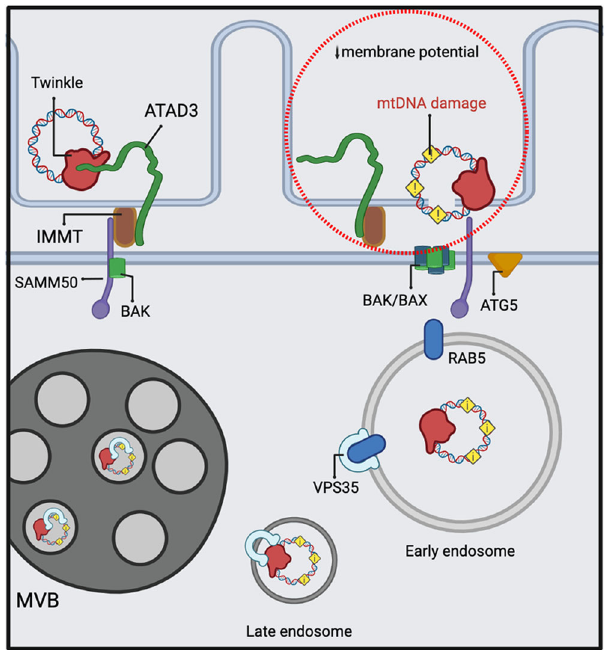
Fig. 9 | Proposed model for mitochondrial nucleoid extraction upon mtDNA damage. MtDNAdamageinduceslocalchangesinmembranepotentialandcristae remodeling. ATAD3 and SAMM50 coordinate to extract mitochondrial nucleoids probably throughBAK/BAXpores. Mitochondrial nucleoids containing mtDNA are engulfed or transferred to early endosomes. VPS35 mediates the maturation of these vesicles to late autophagy structures. The image was generated with full licensed